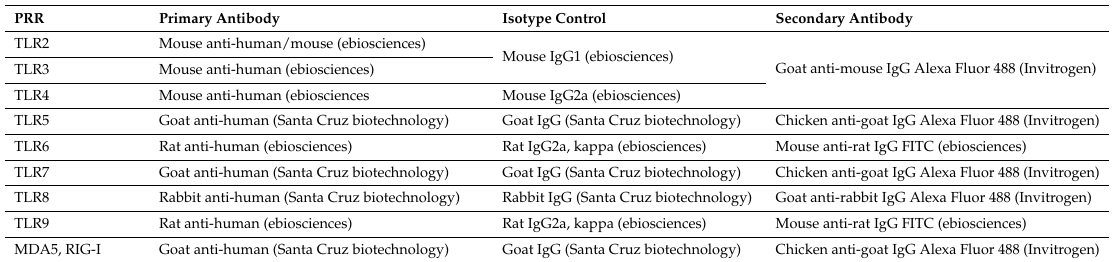
Table 2. Primary and secondary antibodies used for the estimation of PRRs in MK1-OSU and SD-PJEC cells by flow cytometry.